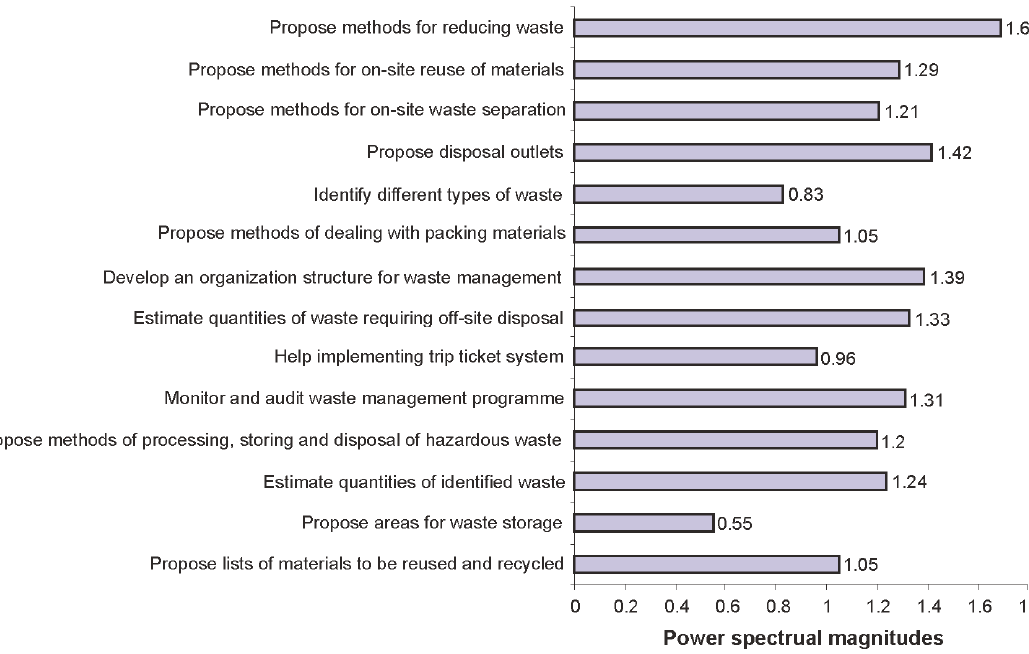
Fig. 5. Benefits in implementing waste management systems